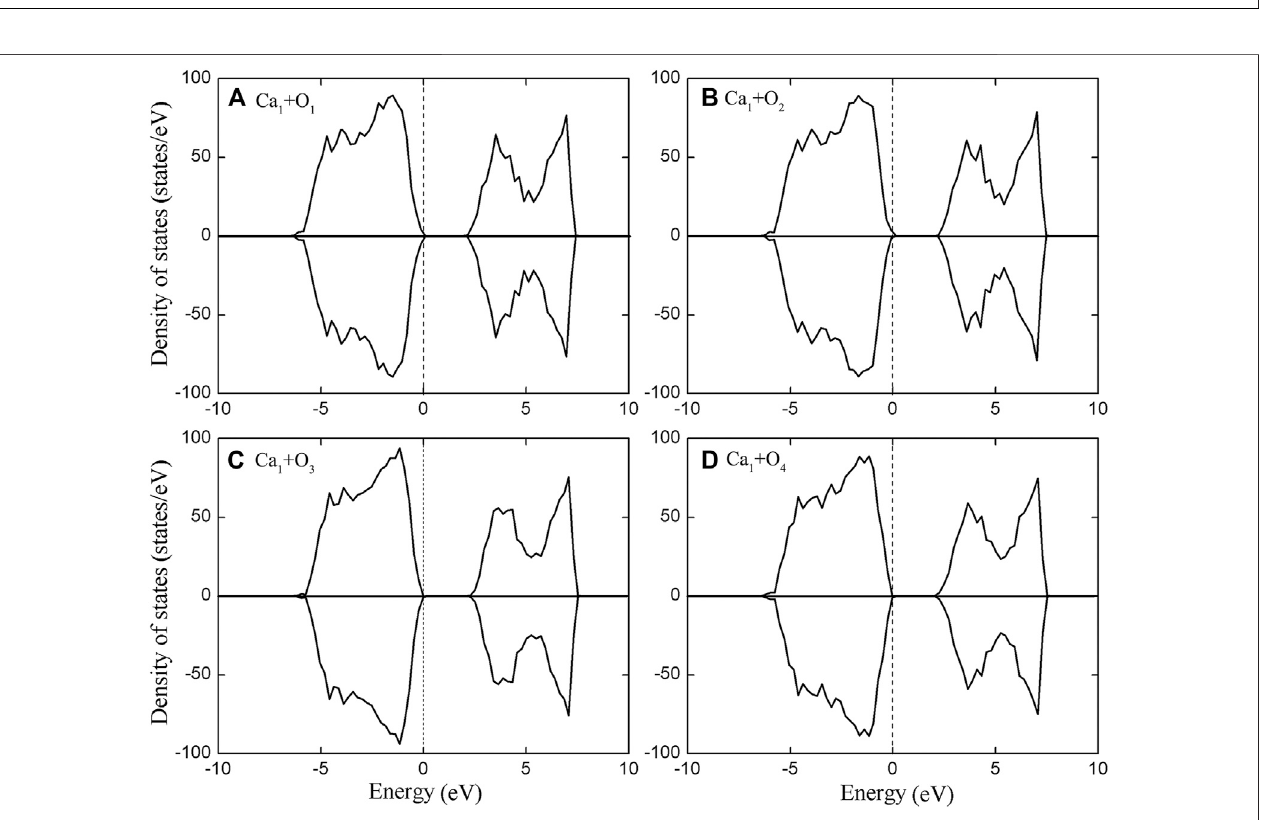
FIGURE 5 | DOSs of Ca 2 Nb 2 O 7 (010) surface with the complex vacancy of VCa+O in the distributions of Ca 1 +O 1 (A) , Ca 1 +O 2 (B) , Ca 1 +O 3 (C) , and Ca 1 +O 4 (D) .